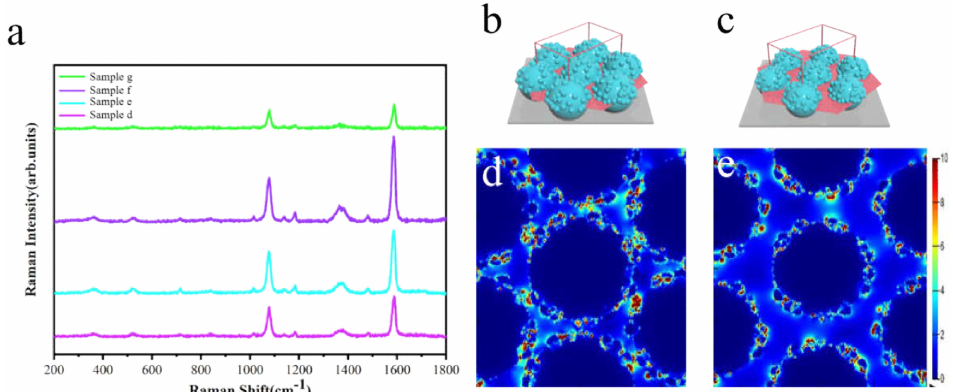
Figure 2. ( a ) SERS spectra of the 4-MBA probe molecules absorbed onto sample d–g. ( b , c ) Ideal morphology of the structures used in the FDTD simulation: the light slices represent the locations of the frequency-domain field monitor. ( d , e ) Cross-section of the local electric field distribution of the corresponding